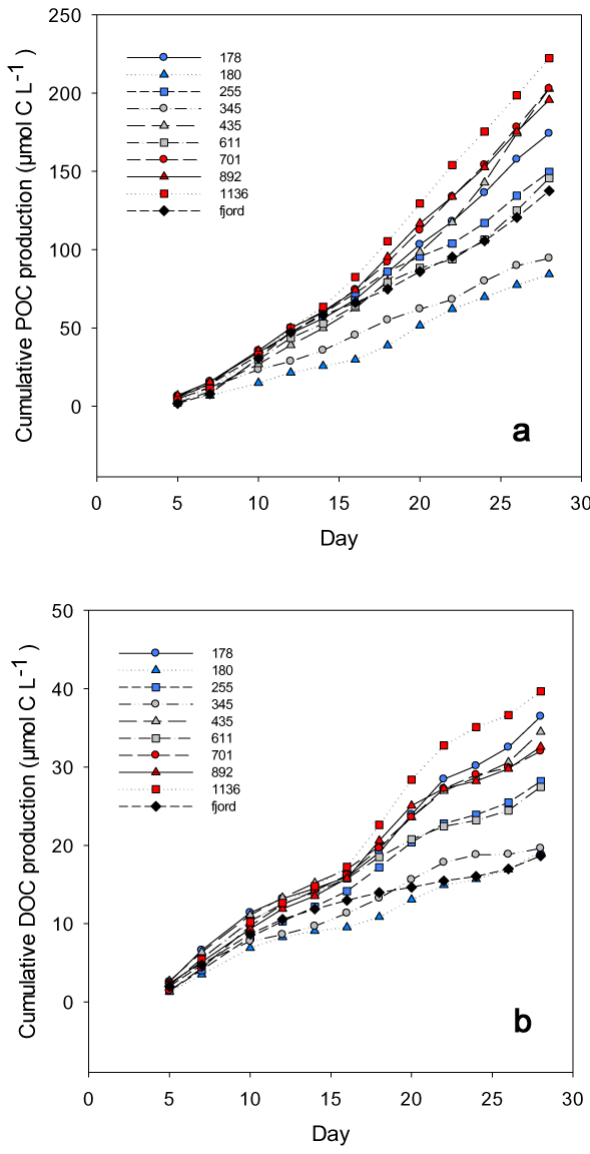
Fig. 5. Cumulative primary production of POC (a) and of DOC (b) as determined from 14 C-bottle incubations for the different meso- cosms and for the fjord. Values for p CO 2 are the arithmetic mean of data over the full period of observation (day 5–day